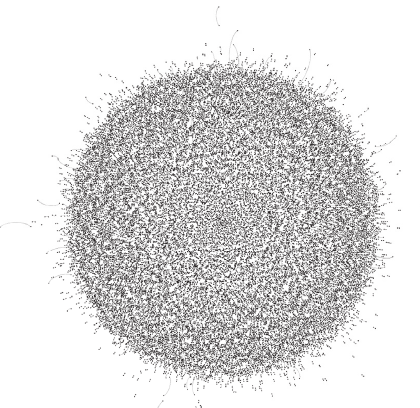
Figure 3: Unprocessed graph of Coauthor dataset.